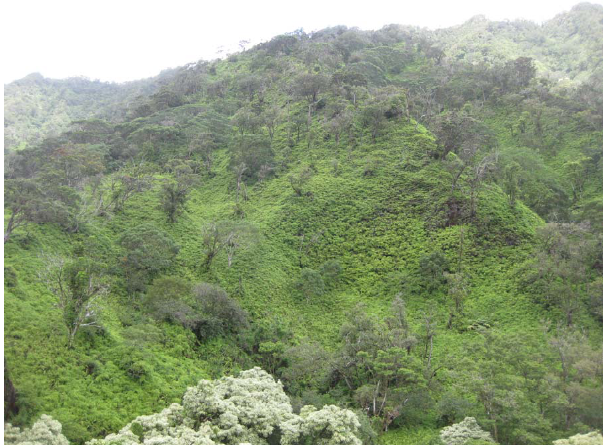
Fig. 13c. Metrosideros gap-formation dieback in the 2.6 million year old Ko`olau mountain range on O`ahu island. Here the outcome indicates development of fern ( Dicranopteris linearis) savannas. The light-green metallic foliage reaching from below belongs to Aleurites moluccana (kukui tree, a Polynesian introduction, which now occupies many stream gullies on O`ahu island).